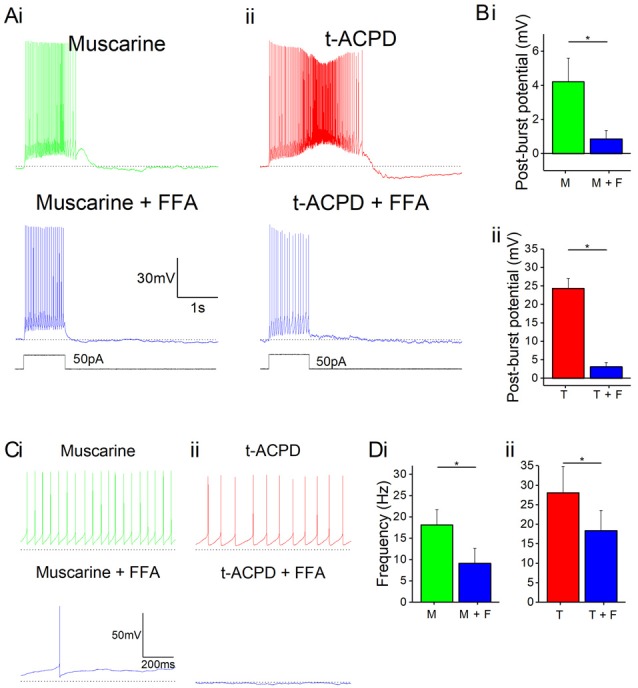
mAChR and mGluR agonist-induced effects can be reversed by a non-specific transient receptor potential (TRP) channel blocker, flufenamic acid (FFA). (A) Example traces showing plateau potentials induced (upper traces) by application of 10 μM muscarine (Ai) or 15 μM tACPD (Aii) are blocked by the addition of the non-specific TRP channel blocker, FFA (50 μM; lower traces). (B) Summary plots of post-pulse potential following application of FFA in the presence of either muscarine (Bi; n = 5) or tACPD (Bii; n = 4). In both cases, it was significantly reduced. (C) Example traces showing spontaneous firing in the presence of muscarine (Ci) or tACPD (Cii) before (upper trace) and after (lower trace) the addition of FFA. (D) Summary plots of the spontaneous firing rate following application of FFA in the presence of either muscarine (Di; n = 10) or tACPD (Dii; n = 10). Error bars = SEM. *P < 0.05. The firing rate significantly decreased in the presence of either mGluR or mAChR agonists.